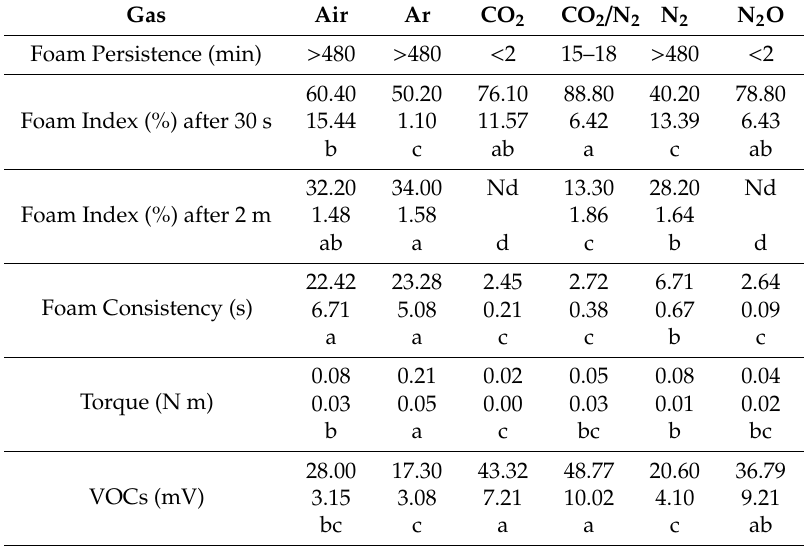
Table 1. Mean and standard deviation of physical and chemical parameters. Di ff erent letters (a, b, c, and d) indicate statistically significant di ff erences between di ff erent gases relative to the parameter measured. ( p < 0.05 Tukey’s Test). Nd = not detected. VOCs: volatile organic